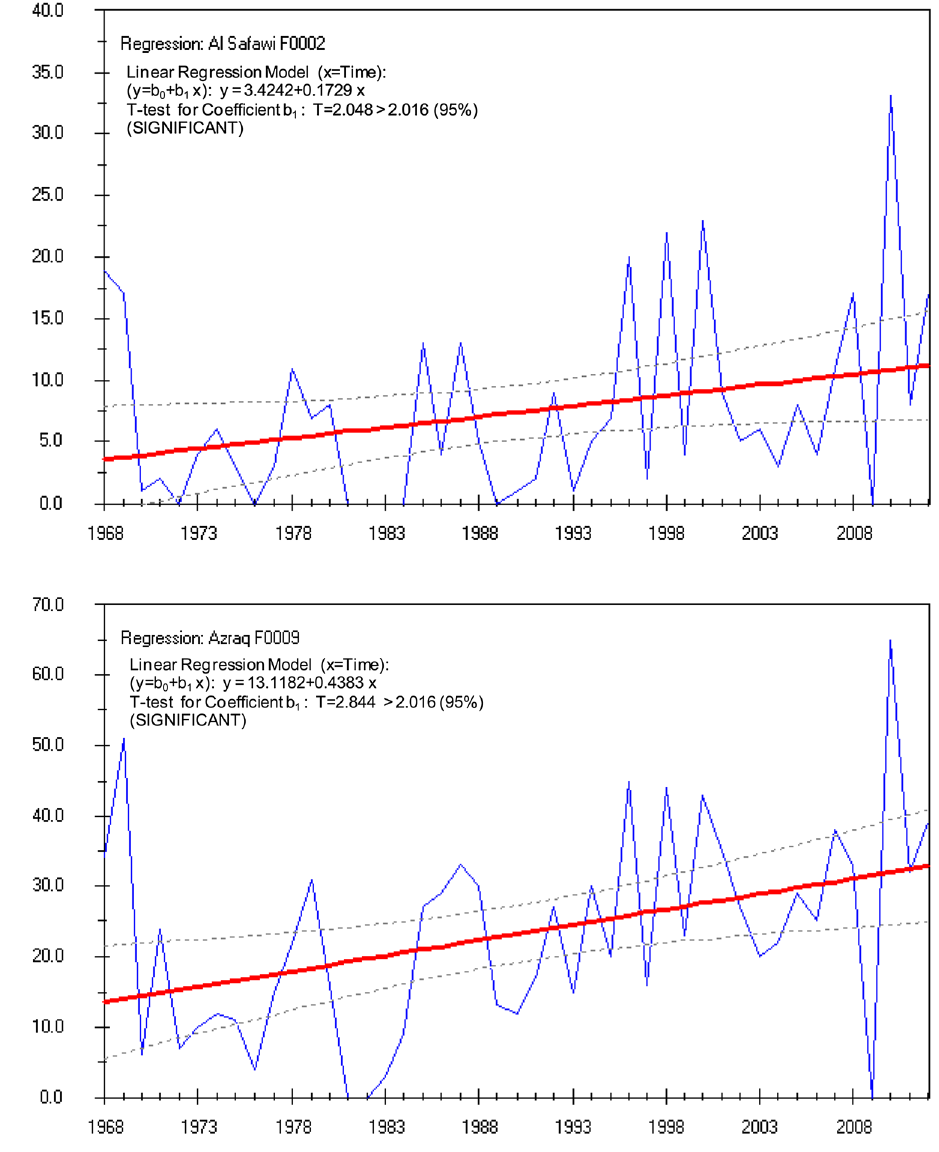
Fig. 8 Minimum temperature frequency (values exceeded 20 °C) in Al Safawi Station